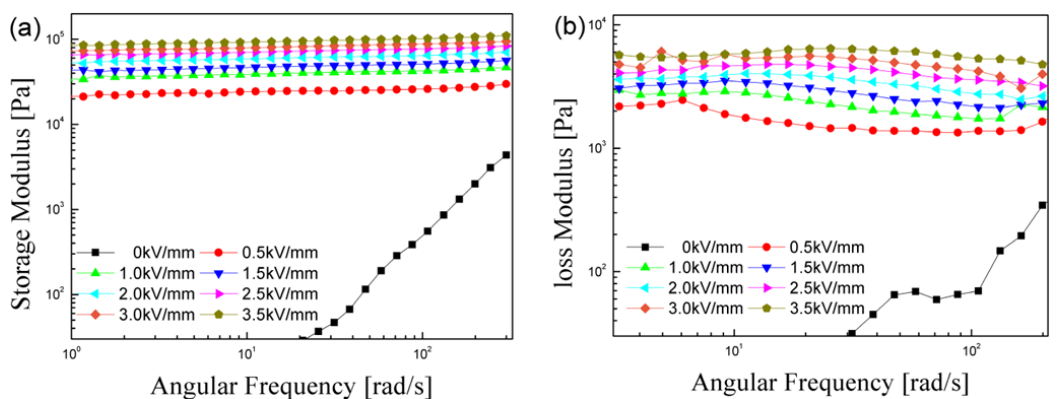
Figure 6. Angular frequency sweep versus G' ( a ) and G'' ( b ) with a fixed strain amplitude of 7 × 10 − 5 for the 10 vol % PMMA-PNMA particle-based ER fluid under various electric field strengths.